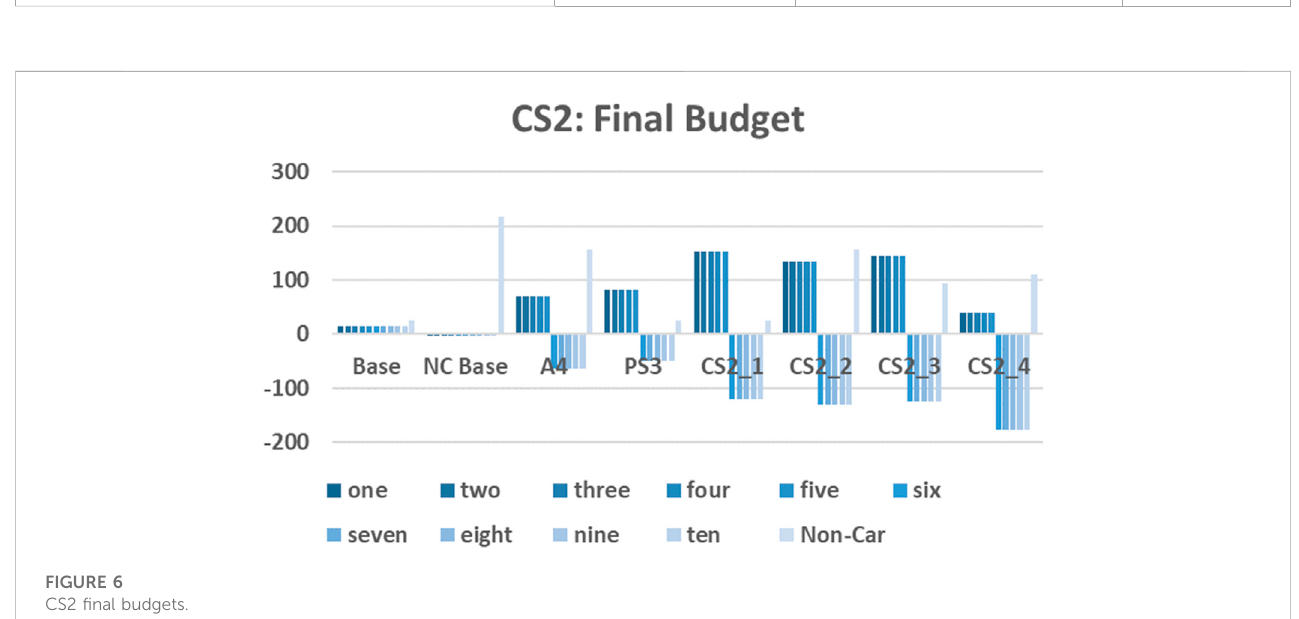
FIGURE 6 CS2 fi nal